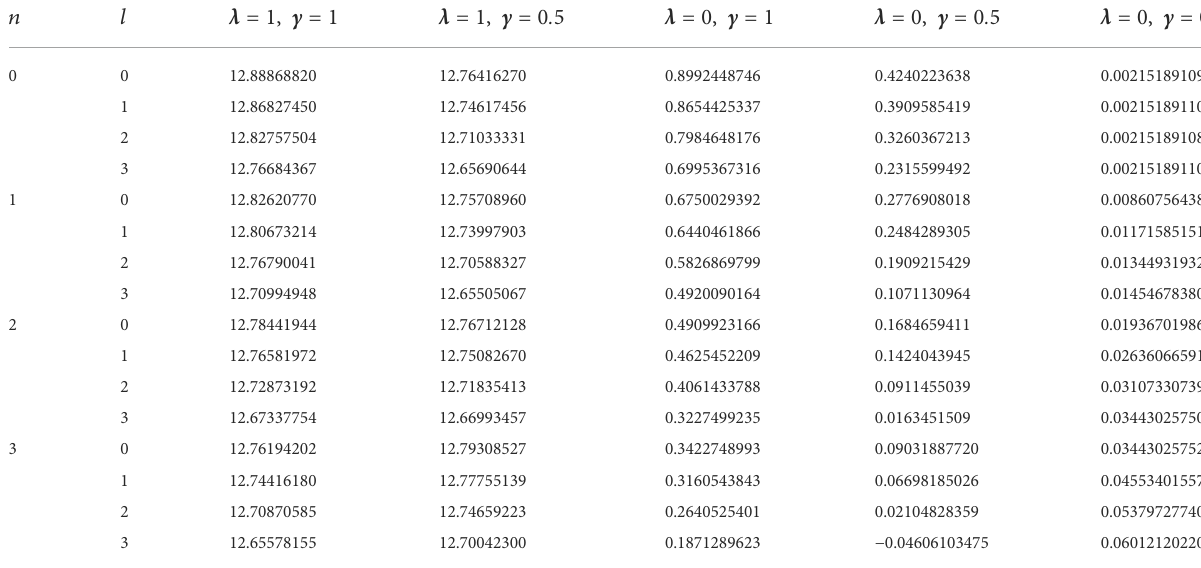
TABLE 2 Energy eigenvalues (− E nl ( eV )) of the shifted screened Kratzer potential for H 2